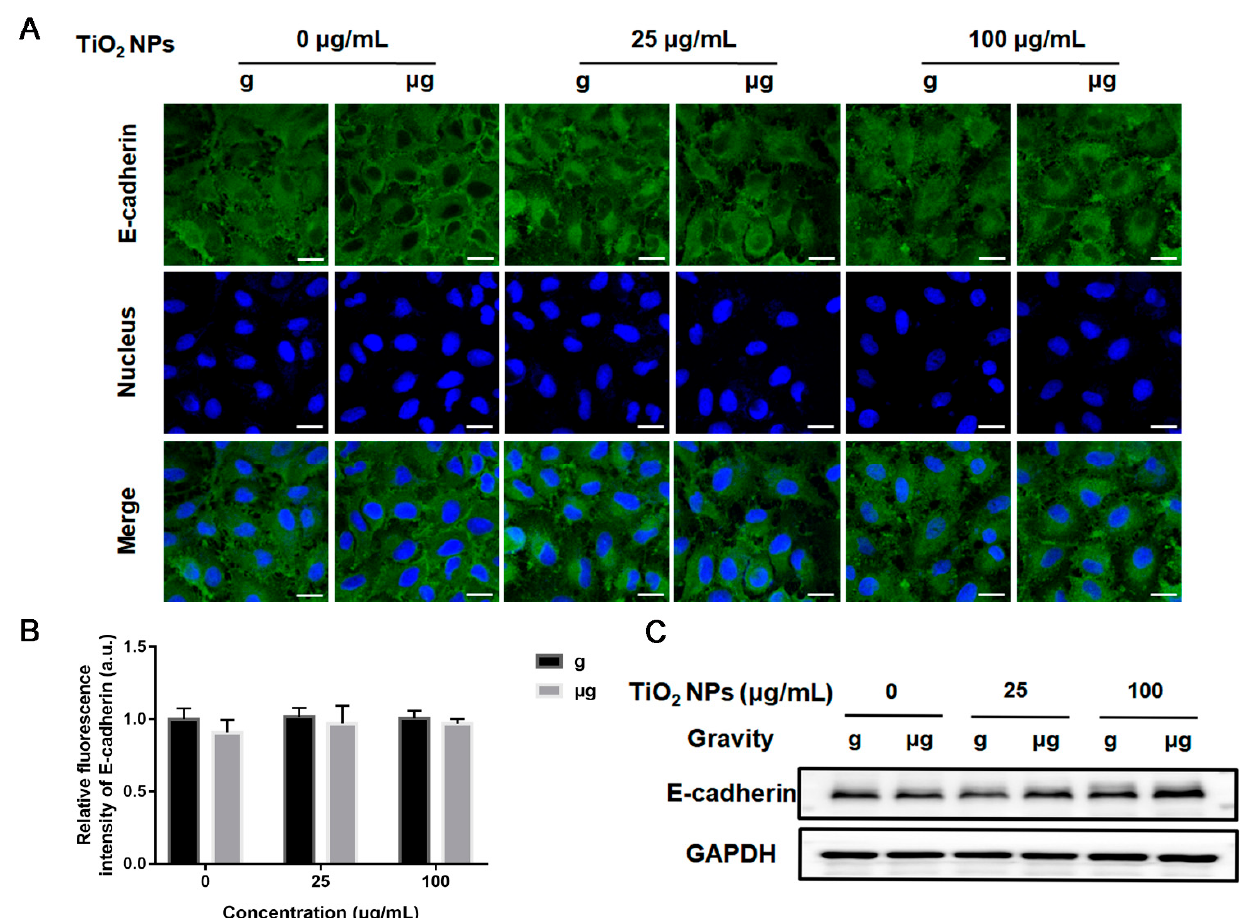
Figure 7. Effect of TiO 2 NPs exposure on the expression level of E-cadherin. A549 cells were treated with TiO 2 NPs (0, 25 and 100 µ g/mL) for 48 h under normal gravity (g group) and simulated microgravity ( µ g group). ( A ) The harvested cells were subjected to immunofluorescence staining for E-cadherin observation using a confocal laser scanning microscope. DAPI was used to stain the nuclei. Representative immunofluorescence images were demonstrated here (scale bar; 20 μ m). ( B ) The quantitative analysis of the fluorescence intensity of each group. ( C ) The representative Western blot results demonstrating the expression levels of E-cadherin in each group of A549 cells.